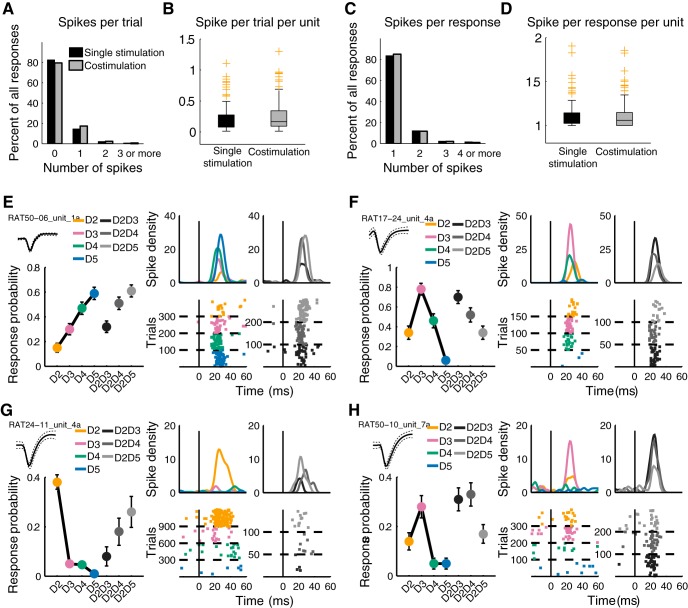
Single unit response properties and examples of recorded units. A, Number of spikes per trial generated by single- and codigit stimulation for all neurons (n = 162) and all trials recorded. B, Distribution of the number of spikes per trial and per unit. The median number of spikes is higher for the codigit than for the single-digit stimulation (Wilcoxon test, p = 0.000). C, Number of spikes per response, i.e., for every trial in which at least one spike was generated. D, Distributions of the mean number of spikes, per response per unit, for single-digit and codigit stimulation. The increased number of spikes per trial is not due to an increase in the number of spikes per response (Wilcoxon test, p = 0.54) but to an increased probability of response (B). E, F, Example of recorded units showing no additive or suppressive effect during costimulation. Left, mean wave form and neuron’s tuning curve represented as a mean response probability (± SD) for each single and codigit stimulation. Right, spike density function and raster plots for both single and combined stimulations (see color code matching digits in the diagrams). G, Unit that shows a distance-dependent suppression after D2 stimulation with an adjacent or nonadjacent digit. H, Unit responding to D2D3 and D2D4 costimulation as if D3, its preferred digit, were stimulated.